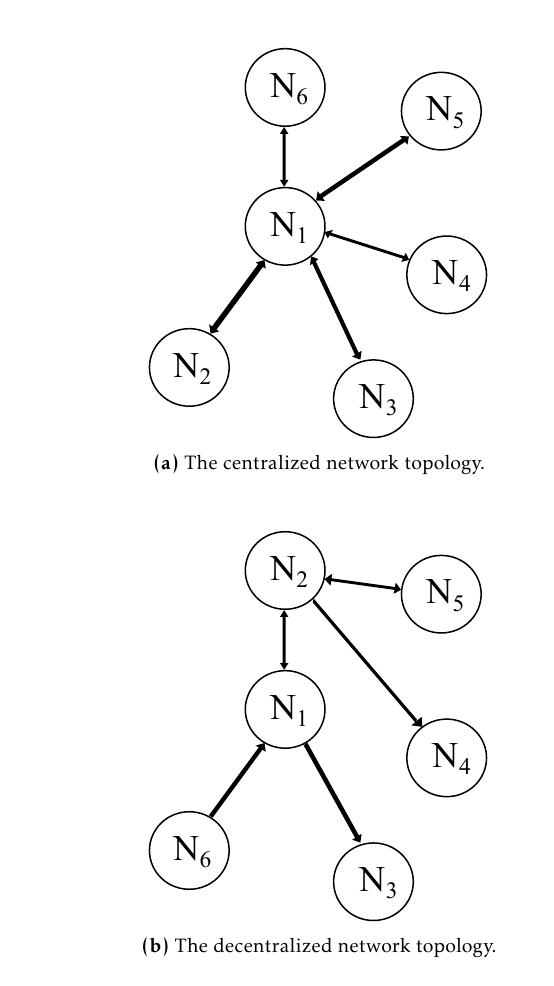
Figure 15. The two topology considered for the six node